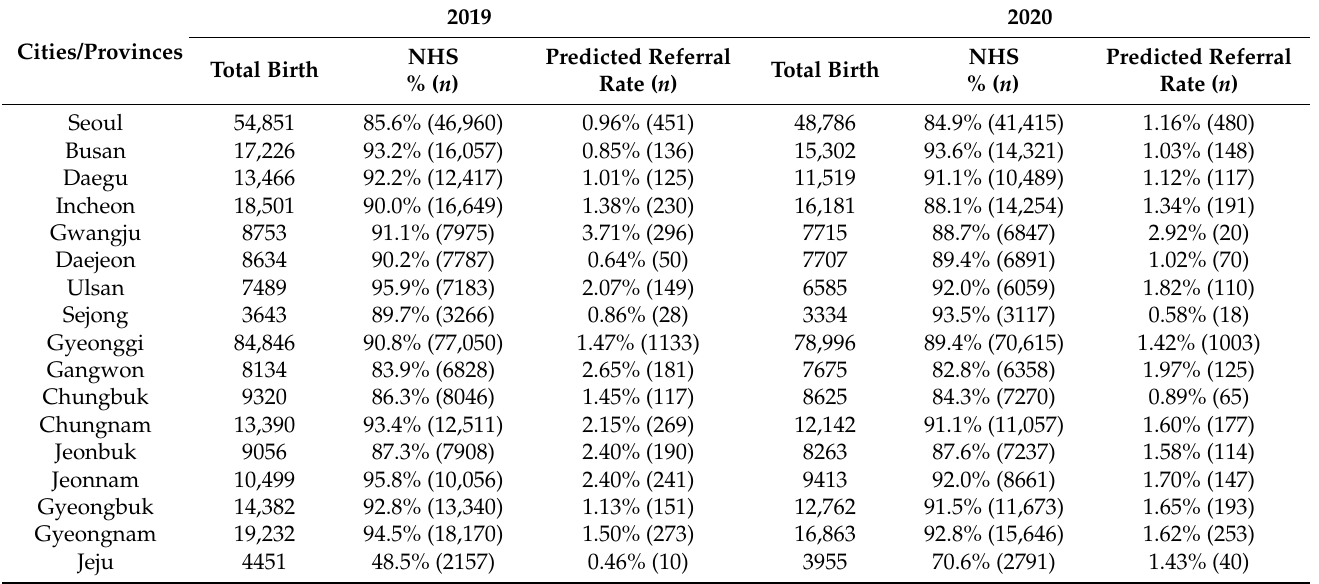
Table 2. Newborn hearing screening status and the predicted referral rates in 17 Korean cities and provinces from 2019 to